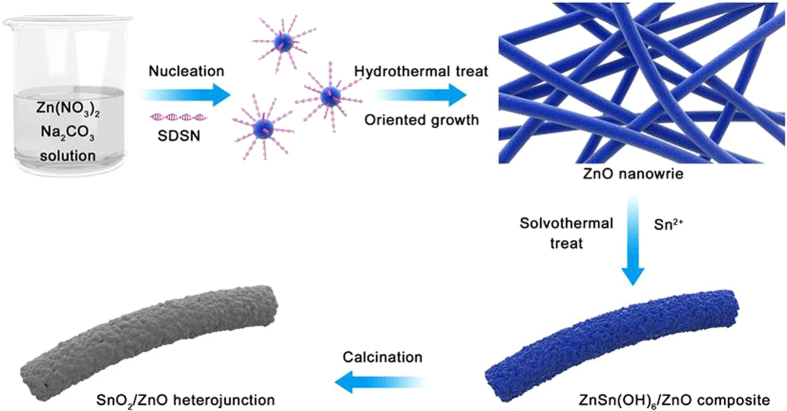
Schematic illustrations for the growth process of the as-prepared SnO2/ZnO NWs heterojunction.